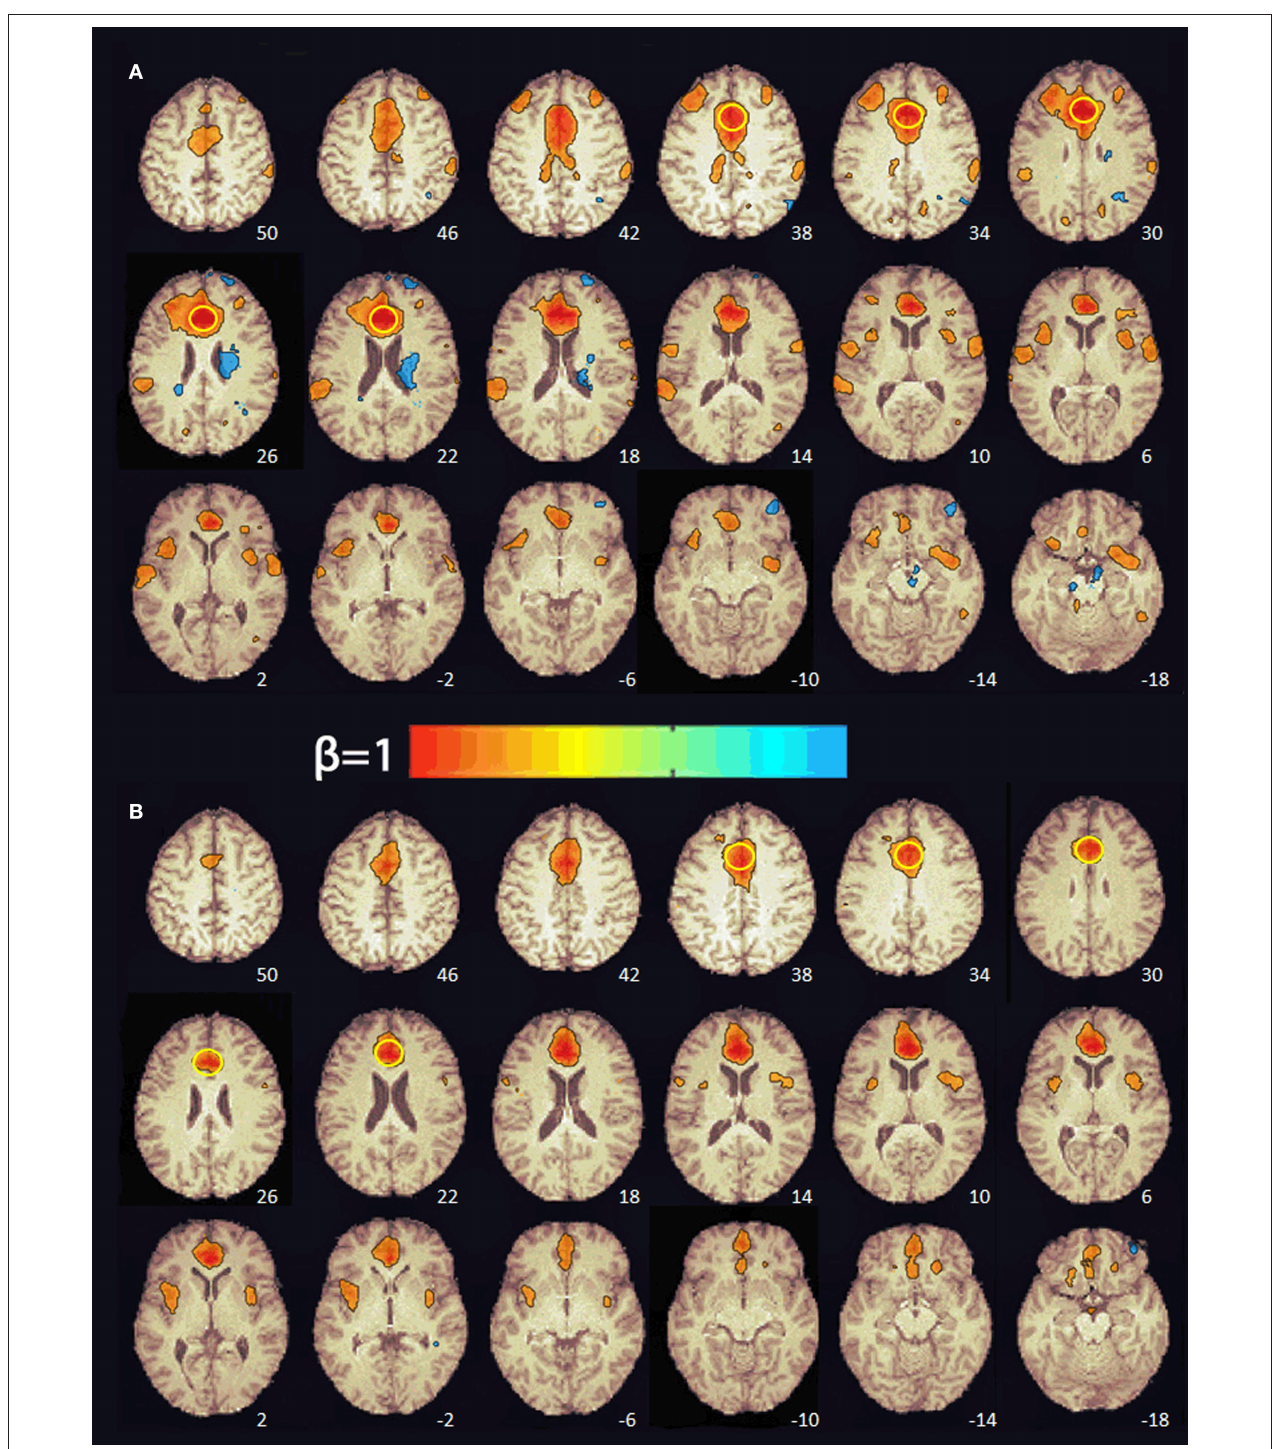
FIGURE 2 | Functional connectivity maps from the pre-treatment (A) and post-treatment (B) scans showing regions functionally connected to the seed in the anterior cingulate cortex. The numbers at the bottom right indicate the z coordinate (mm). The yellow circle denotes the seed in the anterior cingulate cortex. The color bar indicates the beta weight of the functional connections. The maps were thresholded at β ≥ 0.4.